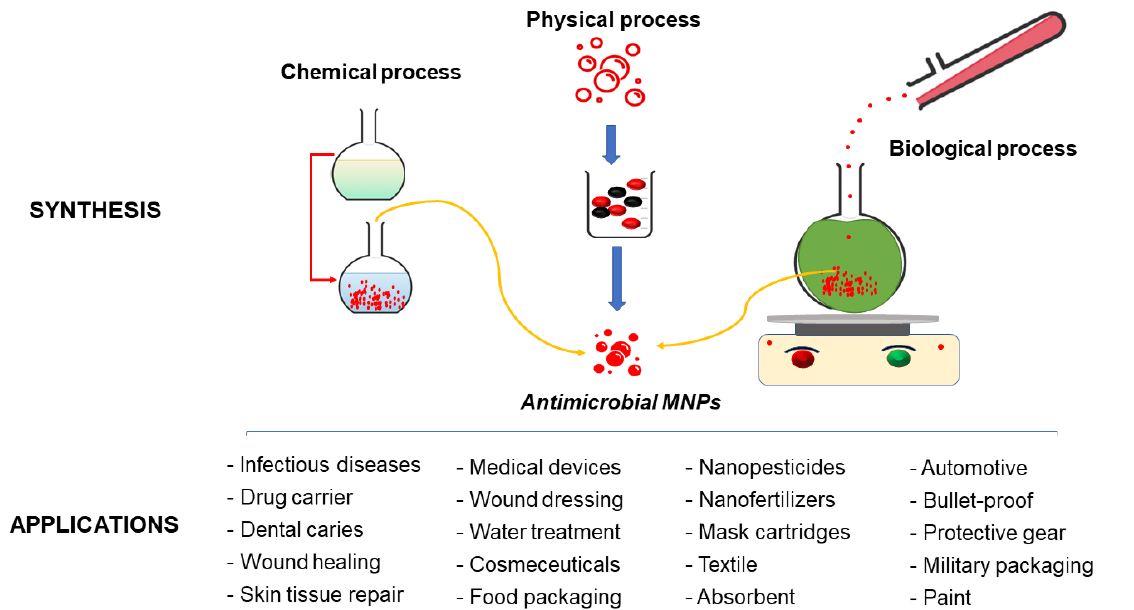
Figure 6. Overview of the different applications of antimicrobial MNPs.